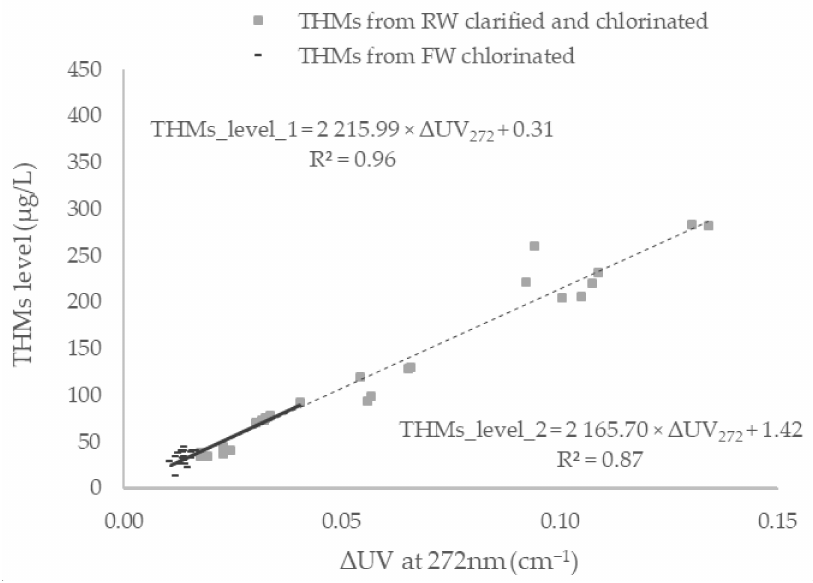
Figure 5. Correlation between trihalomethane (THM) levels and DUVA at 272